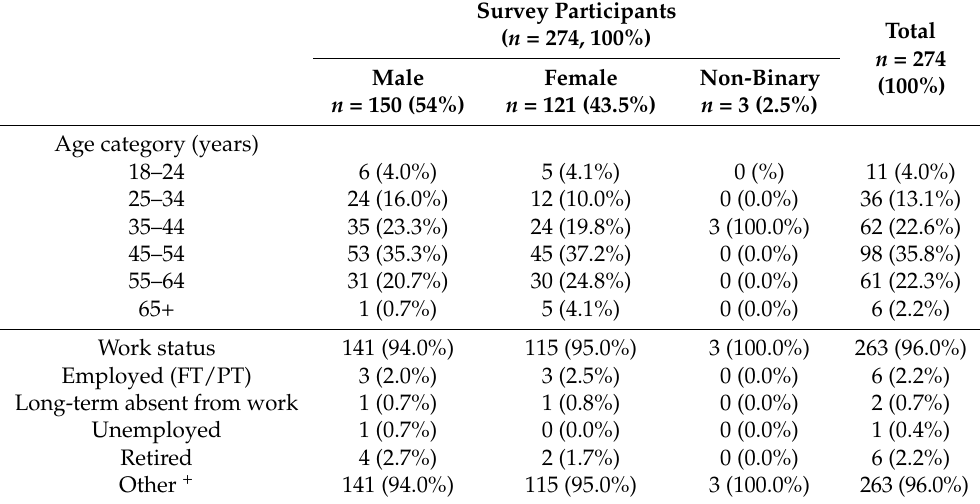
Table 1. Employee characteristics.